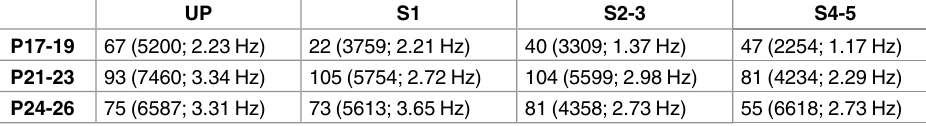
Table 1. Count, the median number of spikes, and the mean firing rate in recording session of pyra- midal neurons used in